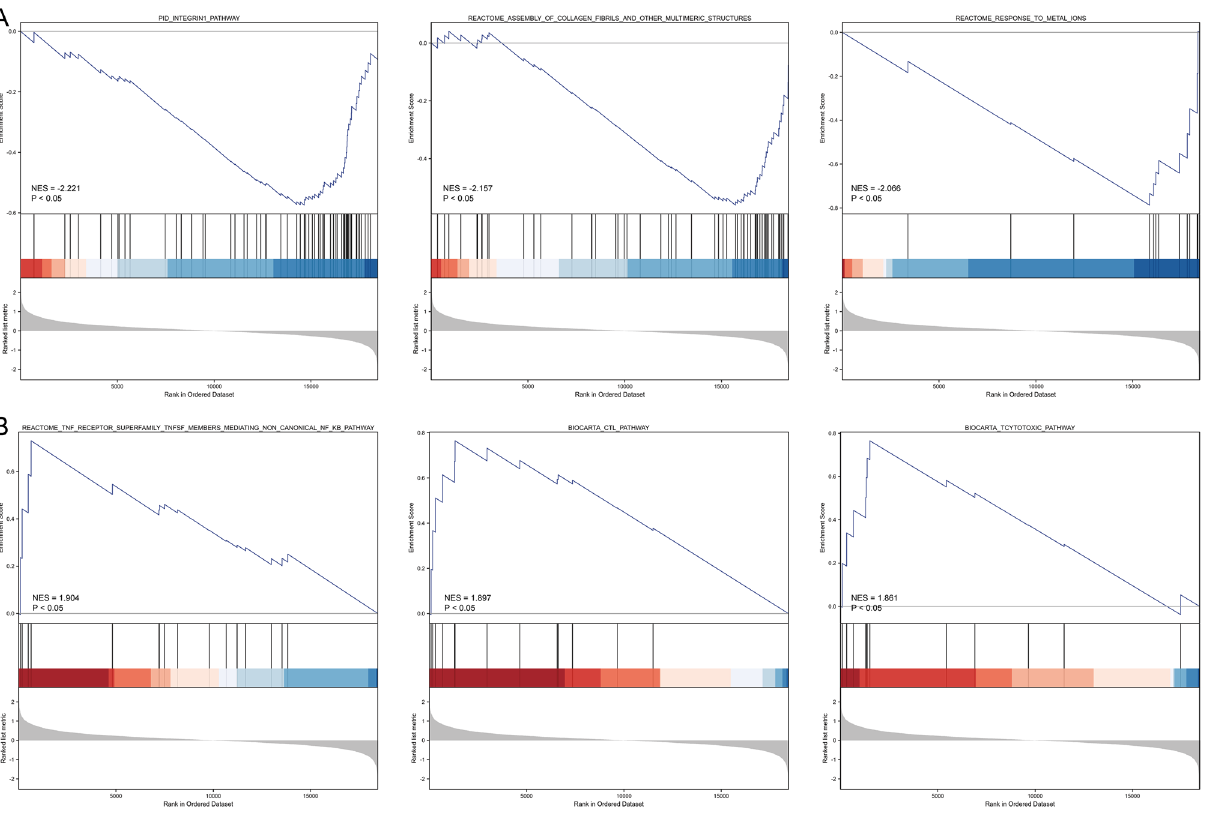
Figure 2. GSEA of ferroptosis-related DEGs in chemoresistance OS patients. ( A ) The top-three most significant-enriched gene sets that negatively correlated with the ferroptosis-related DEGs based on NES value. ( B ) The top-three most significant-enriched gene sets that positively correlated with the ferroptosis-related DEGs based on NES value. type of RCD with unique morphological and biological characteristics, is recognized as promising in modifying cancer chemoresistance and has demonstrated corresponding value in OS chemotherapy 24 . Fu et al. observed that OS cells that underwent ferroptosis behaved more sensitively to adriamycin treatment 25 . Liu et al.